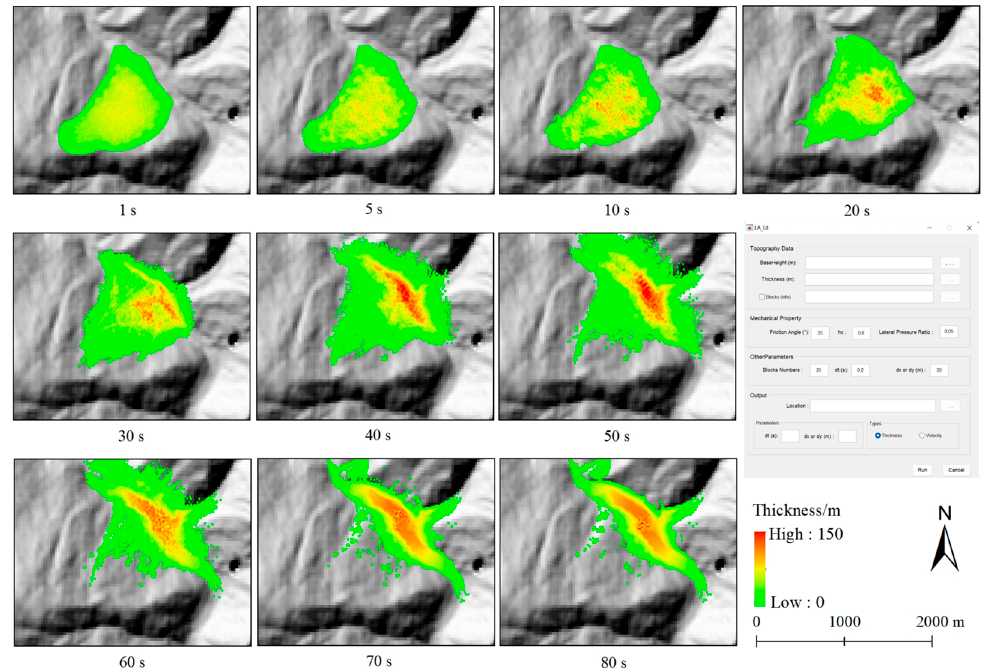
Figure 15. Failure simulation of the unstable rock mass using LA model.